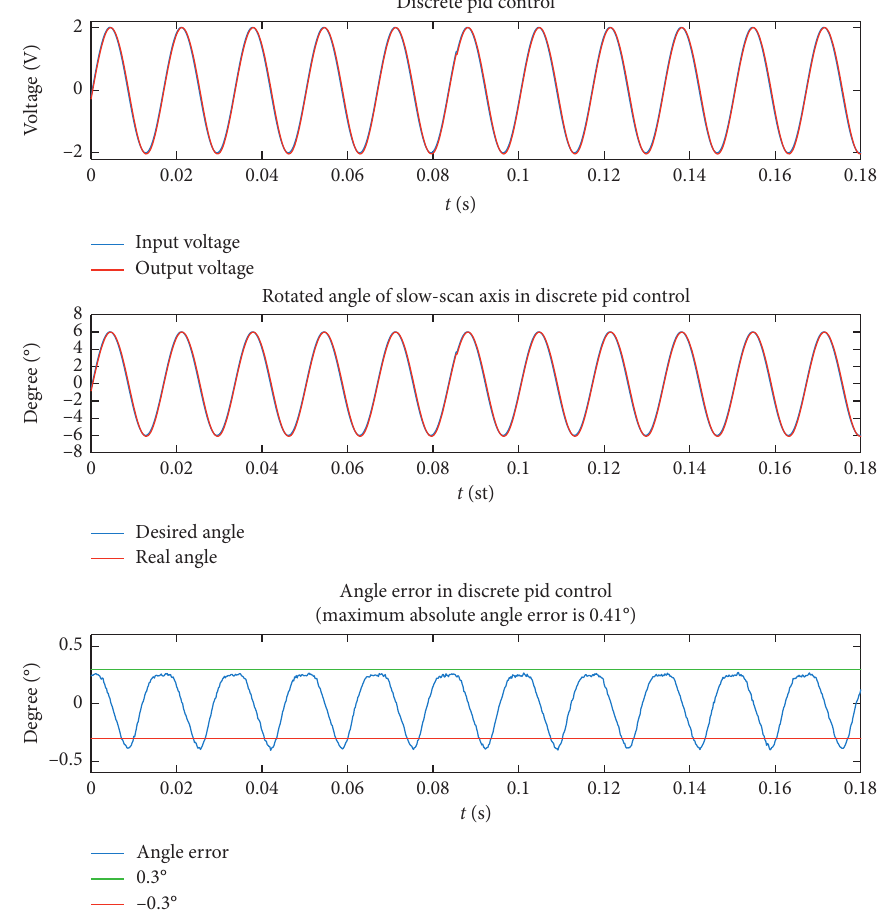
Figure 7: Slow-scan axis control of electromagnetic micromirror in discrete PID